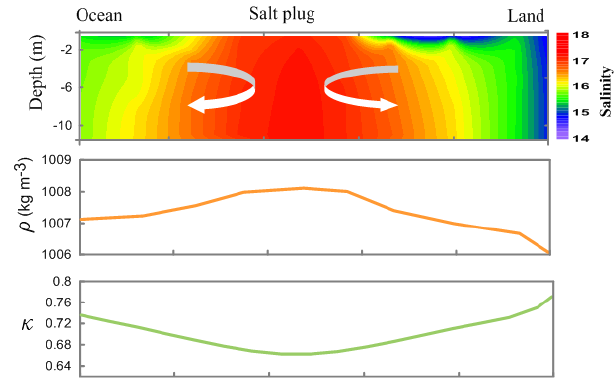
Figure 6. Conceptual diagram of an idealized baroclinic flow in a salt plug. During the dry season when a salt plug is formed, a longi- tudinal density gradient produces a zone of inverse gravitational cir- culation between the salt plug and the coastal ocean, and a zone of positive gravitational circulation near the river area. Van der Burgh’s coefficient ( K) indicates a gradual increase seaward and landward from the center of the salt plug, similar to inverse and positive estu- aries, respectively. This shows that K works in the opposite direc- tion, when gravitational circulation is